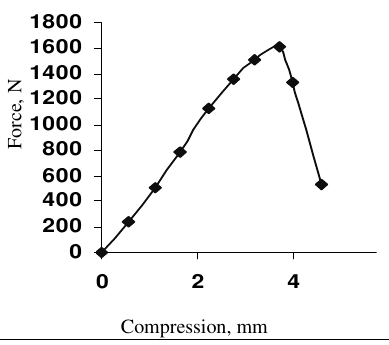
Figure 7. Compressive strength of SF- Rnf composite